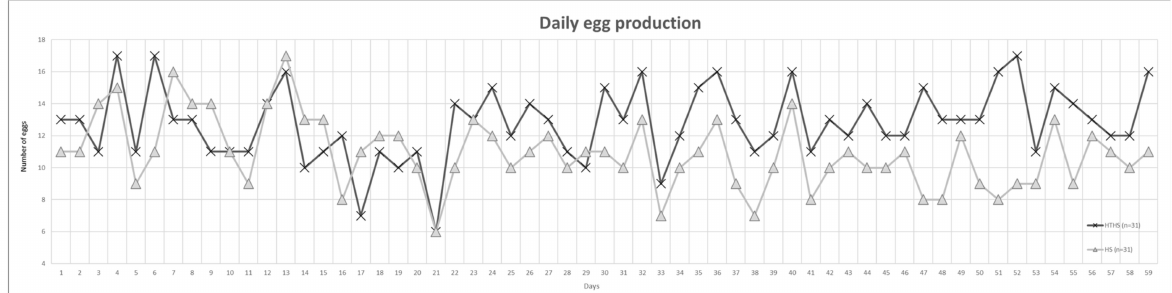
Figure 2. Demonstration of the daily egg production and the ratio of fertilized eggs in heat-treated (HTHS) and control (HS) groups under heat stress. The egg collection began from the 24th life week but the data in the figure presents the egg number from the 27th life week because the egg production was stable from this